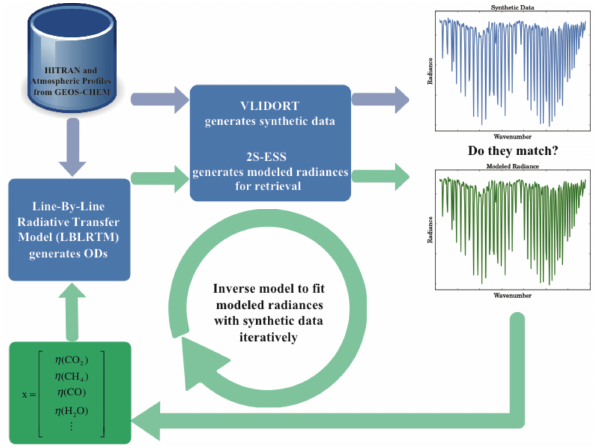
Figure 2. The set-up for simulated retrievals. Realistic atmo- spheric profiles are obtained from GEOS-CHEM and line posi- tions and strengths from the HITRAN 2008 molecular spectro- scopic database. These are then input to a line-by-line radiative transfer model (LBLRTM) to generate optical depths. VLIDORT, a state-of-the-art radiative transfer model, generates the synthetic data after its model output is convolved with the instrument line shape (ILS) and random measurement noise is added. A fast two-stream (2S), enhanced single scattering (ESS) radiative transfer model, 2S- ESS, generates the modeled radiances for retrievals. In simulated retrievals, we first have some prior knowledge about the concentra- tion of gases and other parameters. This a priori is used as input to 2S-ESS to generate the modeled radiances. The state vector x is updated iteratively in an inverse model until the modeled radiances match the synthetic data adequately.